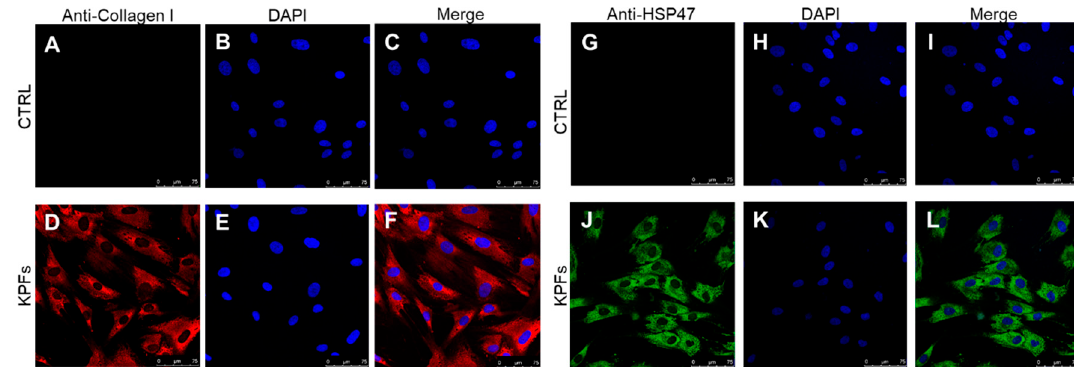
Figure 3. ( A – L ) Cultured fibroblasts isolated from perilesional tissues (KPFs) characterized by confocal microscopy. The use of selective markers such as type I collagen (in red) ( D ) and HSP47 (in green) ( J ) reveals the presence of fibroblast cells in primary cultures. All the visible nuclei (colored in blue) ( E , K ) co-localize with the type I collagen (in red) ( F ) or with HSP47 (in green) ( L ) in KPFs. Control experiments were performed in both cases to verify type I collagen and HSP47 antibodies selectivity ( C , I ), respectively. Secondary antibodies were used without primary antibodies ( A , G ) and cultured cells were stained by DAPI ( B , H ). Scale bar: 75 µm. Biomedicines 2020 , 8 , x FOR PEER REVIEW